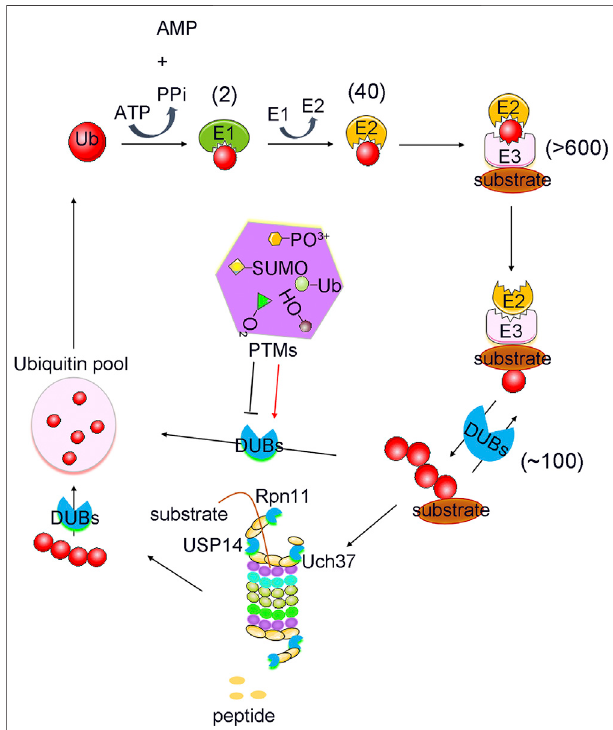
FIGURE1| PTMsmediatedubiquitinationanddeubiquitinationprocess. Protein Ubiquitination is a cascade reaction catalysed by E1 activating, E2 conjugating and E3 ligating enzymes. This can lead tothe formation of distinct types of ubiquitin modi fi cations, all of which can be reversed by deubiquitylating enzymes (DUBs). DUBs are regulated strictly by various post translational modi fi cations (PTMs), including phosphorylation, ubiquitination, SUMOylation, acetylation, oxidation and hydroxylation. Numbers in brackets indicate the number of enzymes in each family.